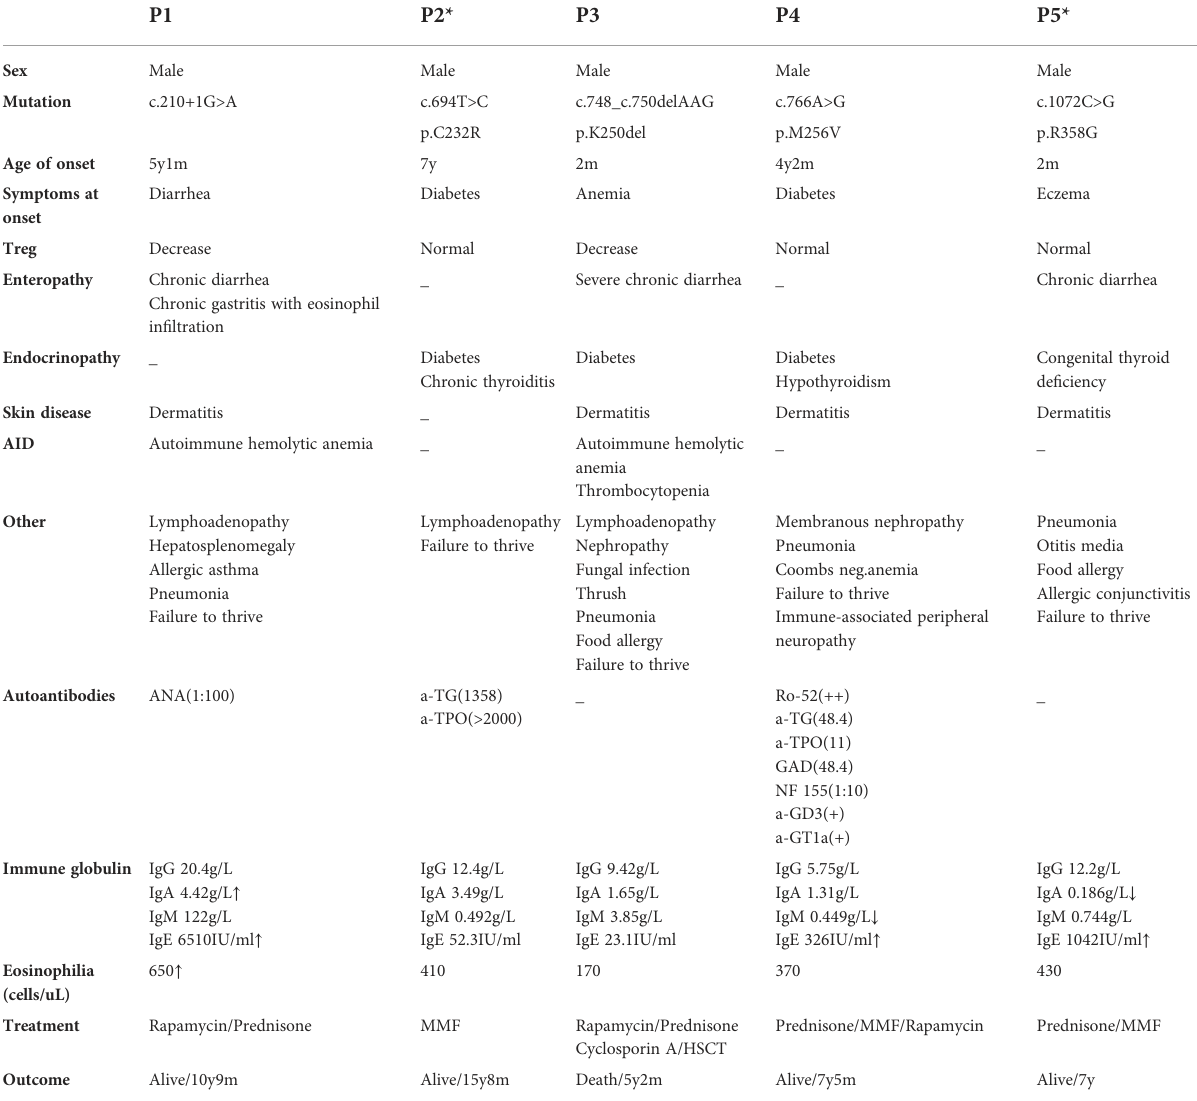
TABLE 1 Summary of the clinical, immunologic, and molecular fi ndings in patients with IPEX syndrome.